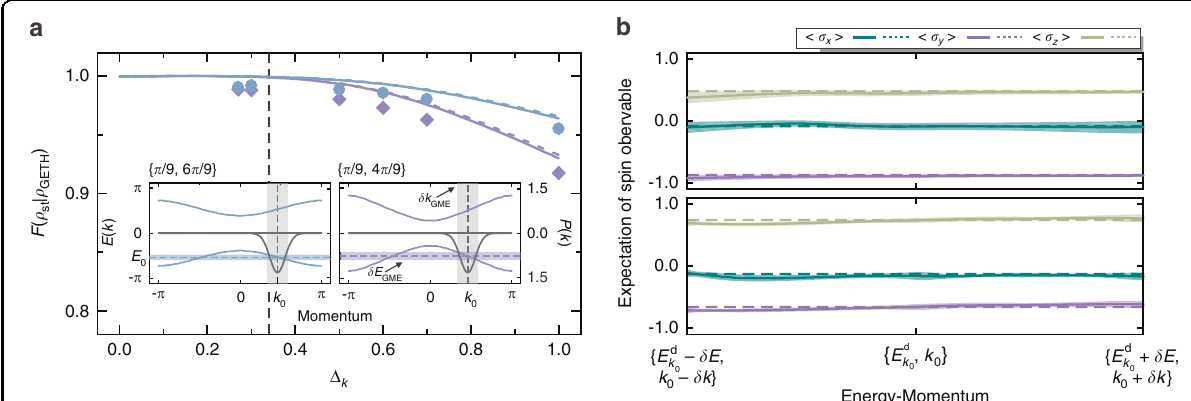
ρ between the measured steady state ρ and GME st j GETH Þ st and ρ , respectively. The dashed black line t ¼ 10 t !1 ; k E d 0 Þ , and GETH ð k 0